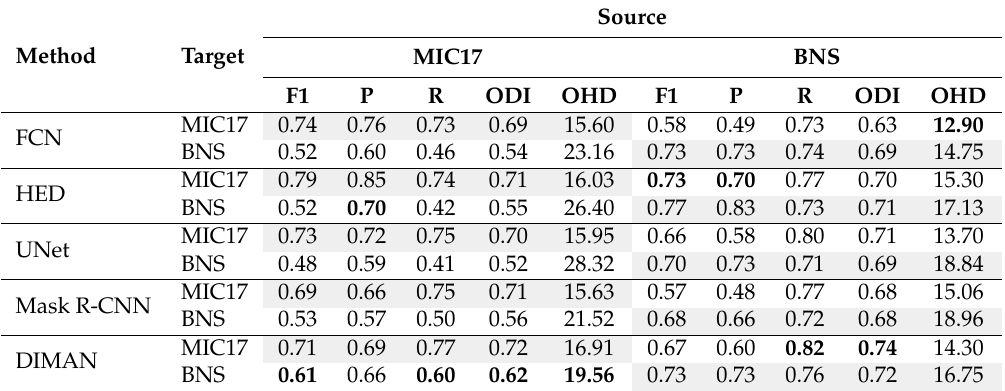
Table 1. Same-dataset (highlighted in grey) and cross-dataset performances of FCN, HED, UNet, Mask R-CNN and DIMAN nuclei segmentation methods. The best cross-dataset result for each target (test) dataset is reported in